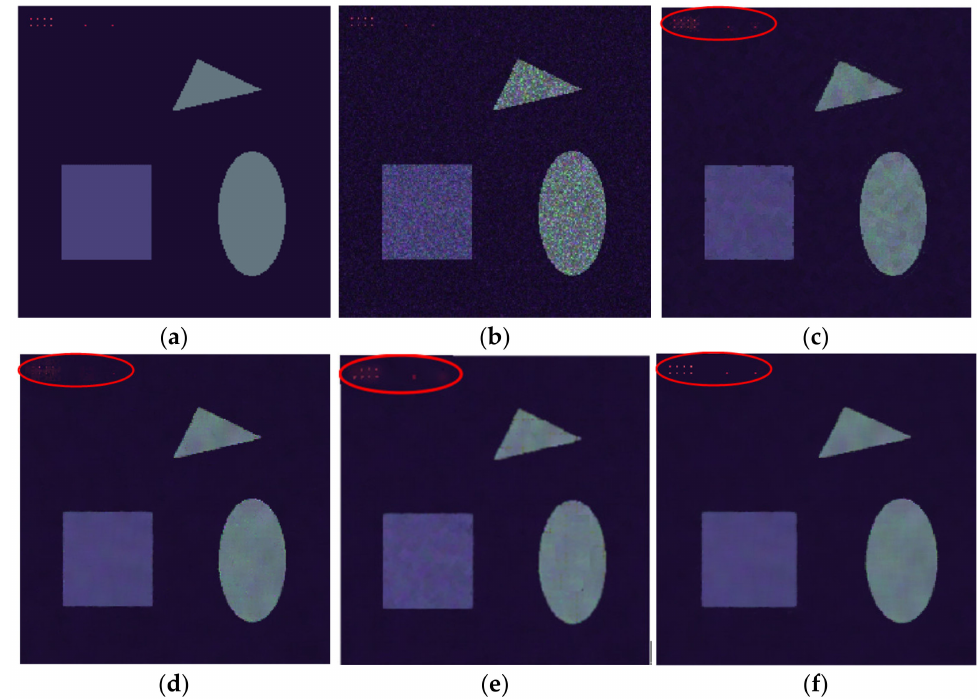
Figure 2. A comparison of different filters using a simulated image: ( a ) Pauli RGB image of the noise-free data; ( b ) single-look speckled image; ( c ) filtering result of the 7 × 7 refined Lee filter; ( d ) filtering result of the NL-means; ( e ) filtering result of PolSAR NLTV; and ( f ) filtering result of NWLMMSE